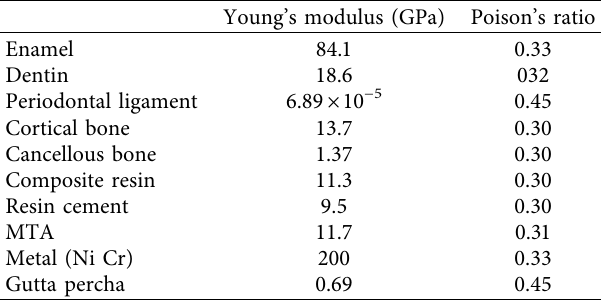
Figure 2: 3D finite element model of immature maxillary central incisor. Table 1: Modulus of Elasticity and Poisson’s ratio of different